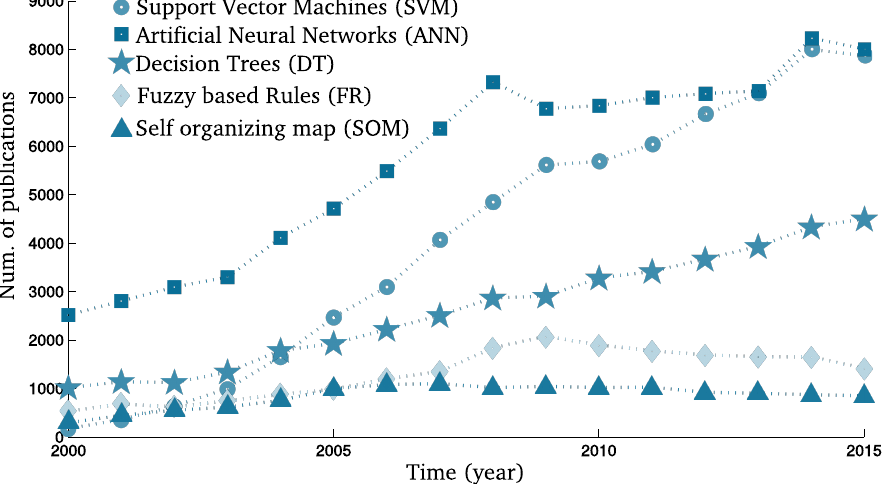
Figure 2. Publication trends for different methods in ML. Each point in the figure represents the number of research publications per year that include the term in the article title, abstract or keywords (source: